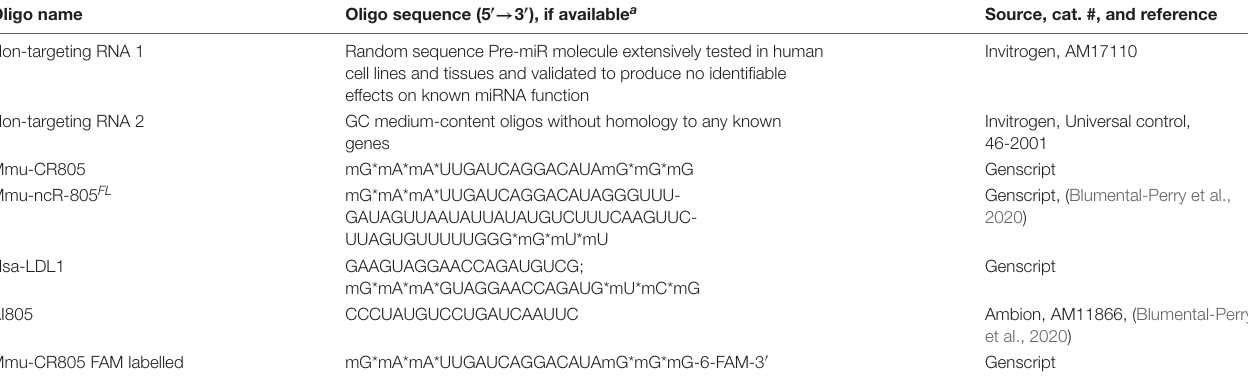
TABLE 1 | List of oligos used in the study. Oligo name Oligo sequence (5 (cid:48) → 3 (cid:48) ), if available a Source, cat. #, and